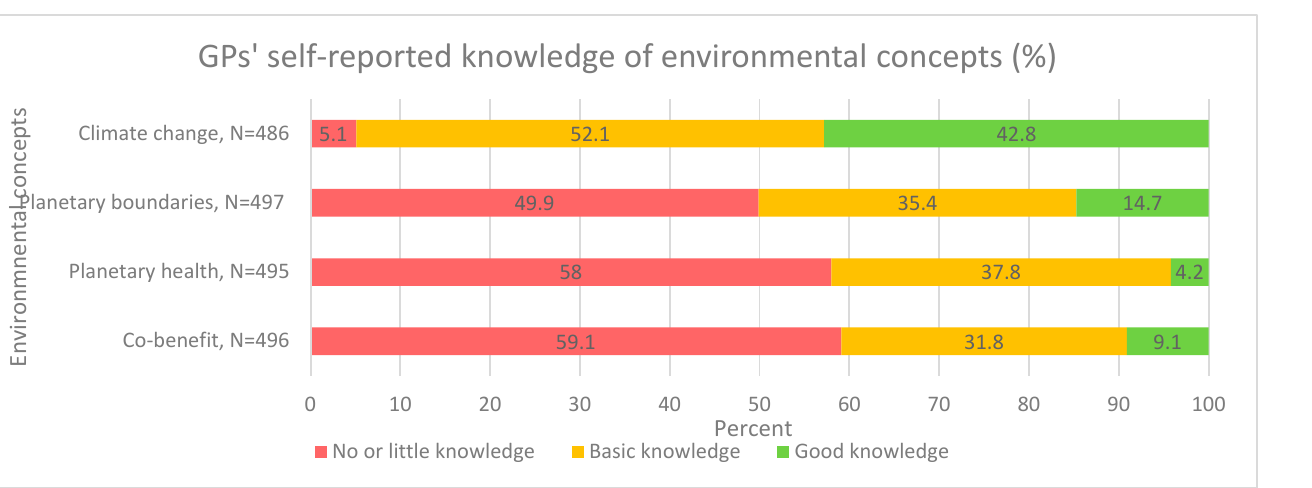
Figure 1. General practitioners’ self-reported knowledge of environmental concepts (%).